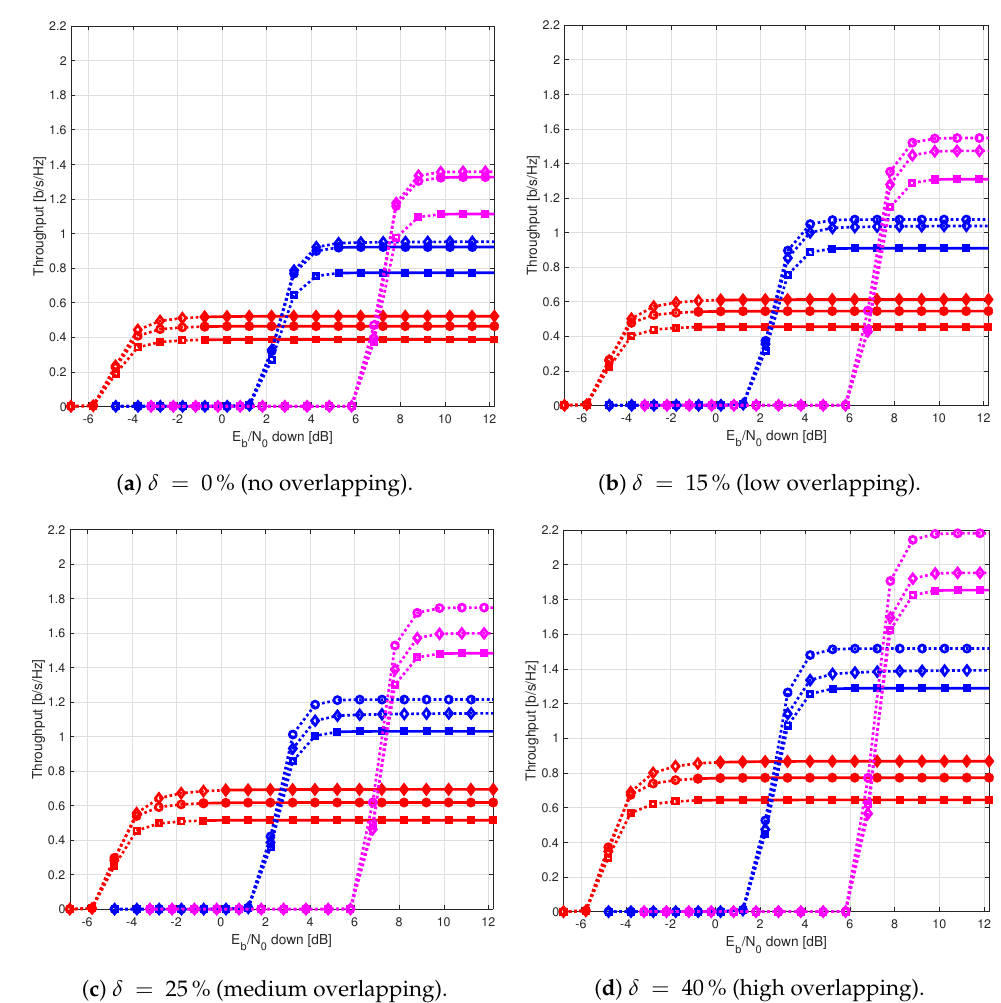
Figure 13. End-to-end throughput versus E b / N 0 in the access link for a regenerative satellite that receives a NB-IoT frame encapsulated in a DVB-S2(X) satellite frame (SNR fl = 15dB). NB-IoT code rates: 1/3 (red), 2/3 (blue) and 0.96 (magenta). DVB-S2(X) code rates: 2/3 (squares), 0.8 (circles) and 0.9 (diamonds). Solid (dashed-) lines with (un)filled markers: BLER ≤ 10 − 2 requirement (not) fulfilled. Wind speed: v = 21m/s. Diameter of telescope aperture: W 0 =